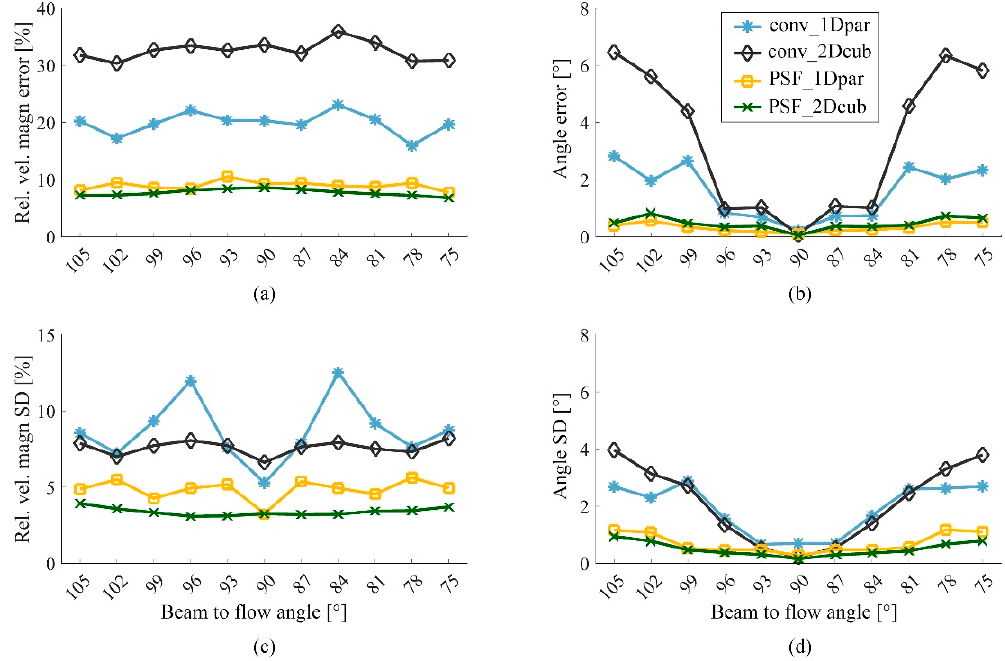
Figure 5. Median absolute bias and SD for the velocity magnitude ( a , c ) and angle ( b , d ), obtained using a PRF of 12.5 kHz. The performance of the four methods is visualized for a range of beam-to-flow